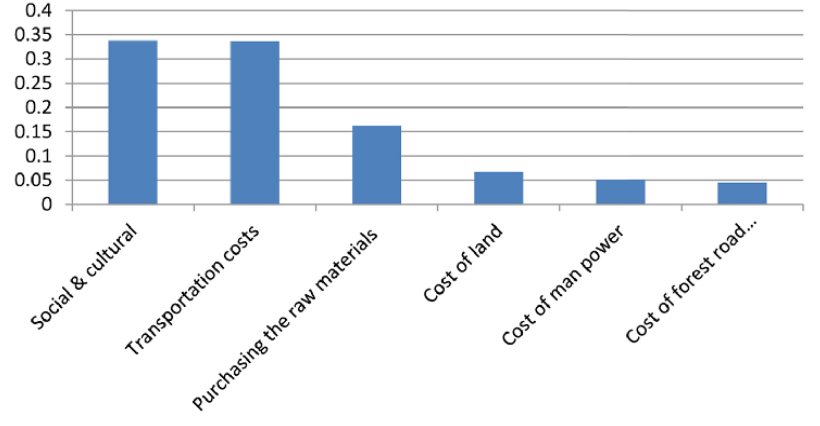
Figure 8: Final synthesis of costs indices (inconsistency rate 0.04), X: Criteria, Y: Weighing